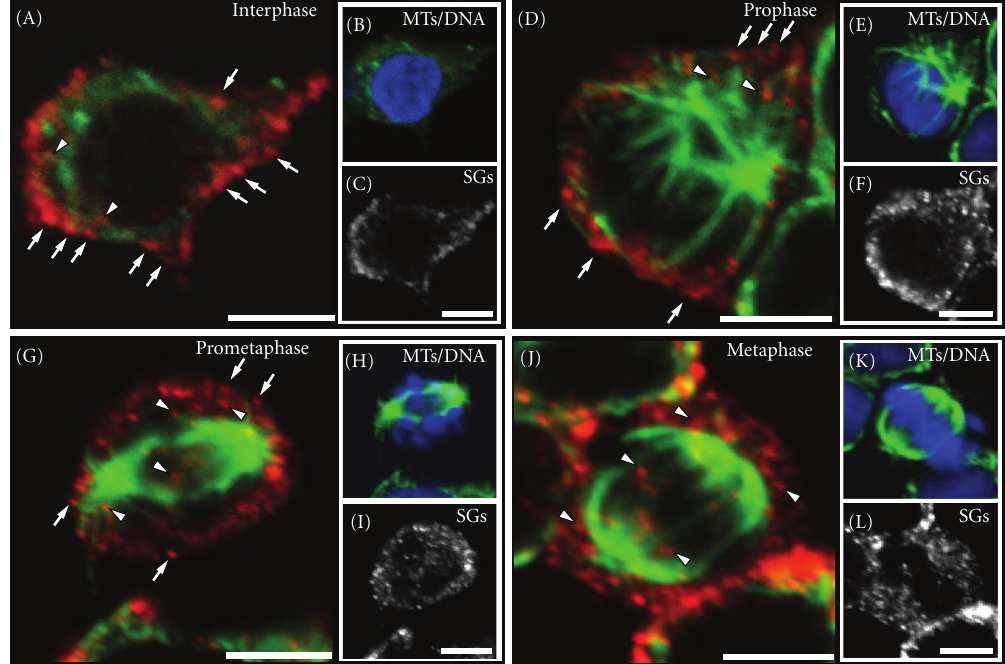
Figure 3: Distribution of SGs during early stages of PC12 cell division. Single confocal planes of representative immunostained PC12 cells at interphase ((A), (B), (C)), prophase ((D), (E), (F)), prometaphase ((G), (H), (I)), and metaphase ((J), (K), (L)) are shown as indicated. In interphase and prophase cells, SGs accumulate in the cell periphery ((A) and (D), arrows), while the number of nonperipherally localized SGs is significantly lower ((A) and (D), arrowheads,). During prometaphase, the number of peripheral SGs is reduced ((G), arrows), concurrent with an increase in the number of SGs in the cytoplasm ((G), arrowheads). SGs exhibited a nearly homogeneous distribution in cells at metaphase ((J), arrowheads) and no accumulation of SGs in the cell periphery could be detected. Scale bars, 5 μ